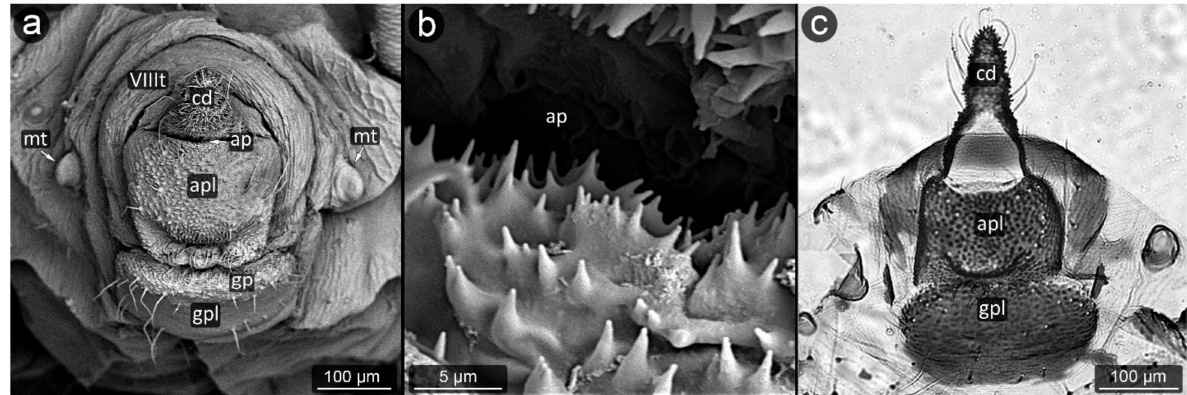
Figure 10. Perianal structure of Aphis jacobaeae ; ( a )—rear view (SEM), ( b )—close-up on the surface of anal plate-protruding spinules (SEM), ( c )— rear view in light